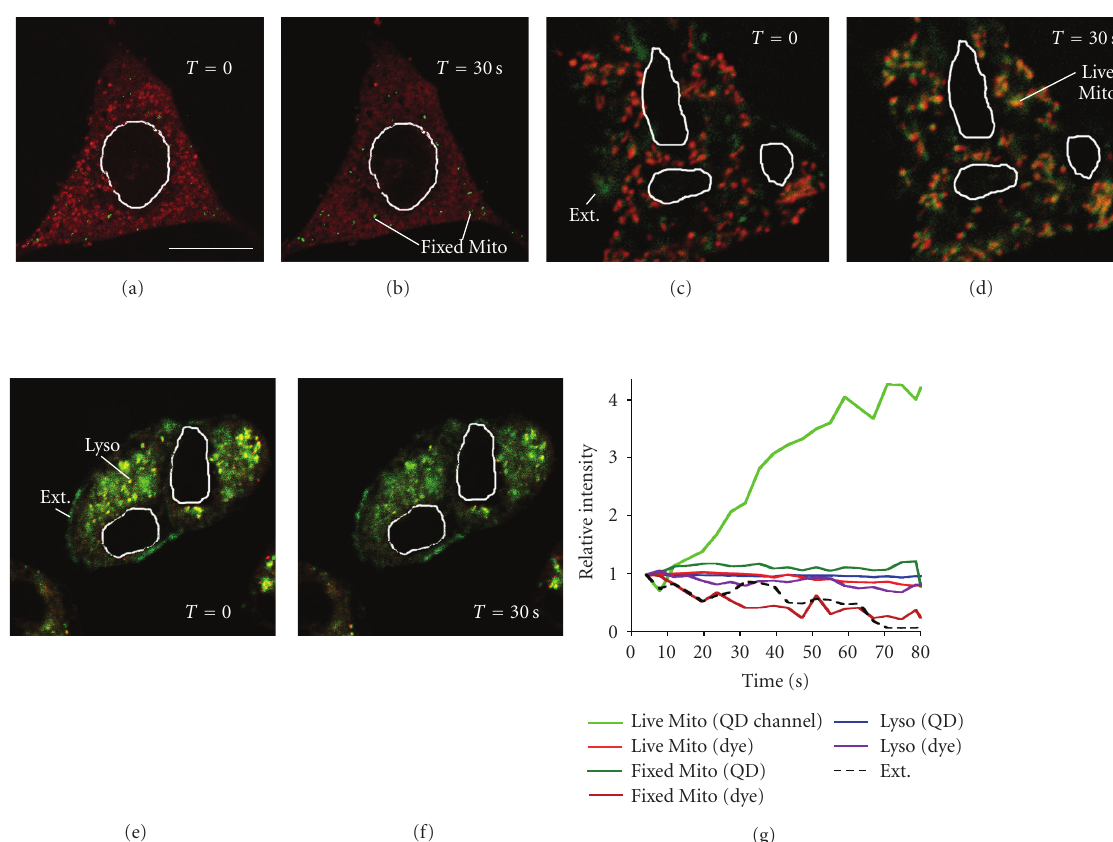
Figure 4: Confocal images and time courses of QD-dopamine with 100 ± 10 DA/particle in PC12-dopamine receptor cells colabeled with organelle dyes. Scale bar = 10 μ m for all panels; in all panels, the green channel indicates the QDs and the red channel the organelle dye. The white lines indicate the cell nuclei. (a) Paraformaldehyde-fixed cell labeled with MitoTracker and QDs. (b) The same cell after 30 seconds of laser-light exposure. (c) Live cells labeled with MitoTracker and QDs. (d) The same cells after 30 seconds of laser-light exposure. (e) Live cell labeled with LysoTracker and QDs. (f) The same cell after 30 seconds of light exposure. (g) Relative intensities from the indicated regions over 100 seconds of exposure